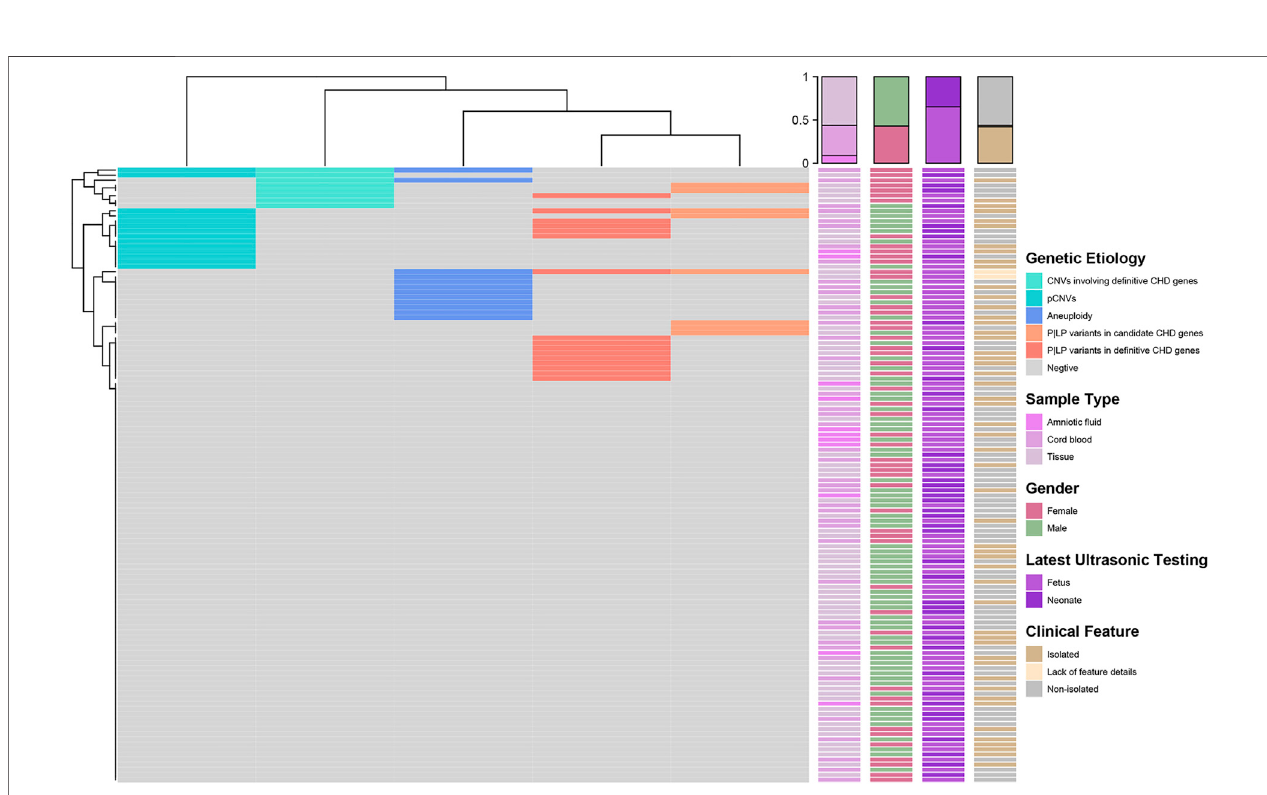
FIGURE2| Landscape ofdistribution ofgenetic etiologyand clinicalfeatures( N =121). Theheatmap ontheleft demonstrated the distribution ofgenetic etiologies detected in each sample. Each row represents a sample and the columns are fi ve categories of genetic etiology. The correspondence colors of genetic etiology were summarized in the right legend. Four clinical characteristics including sample types, gender, latest ultrasonic testing, and clinical features of each sample were demonstrated in the right heatmaps separately. At the same time, we also displayed the distribution statistics of clinical characteristics on the top of the heatmap.